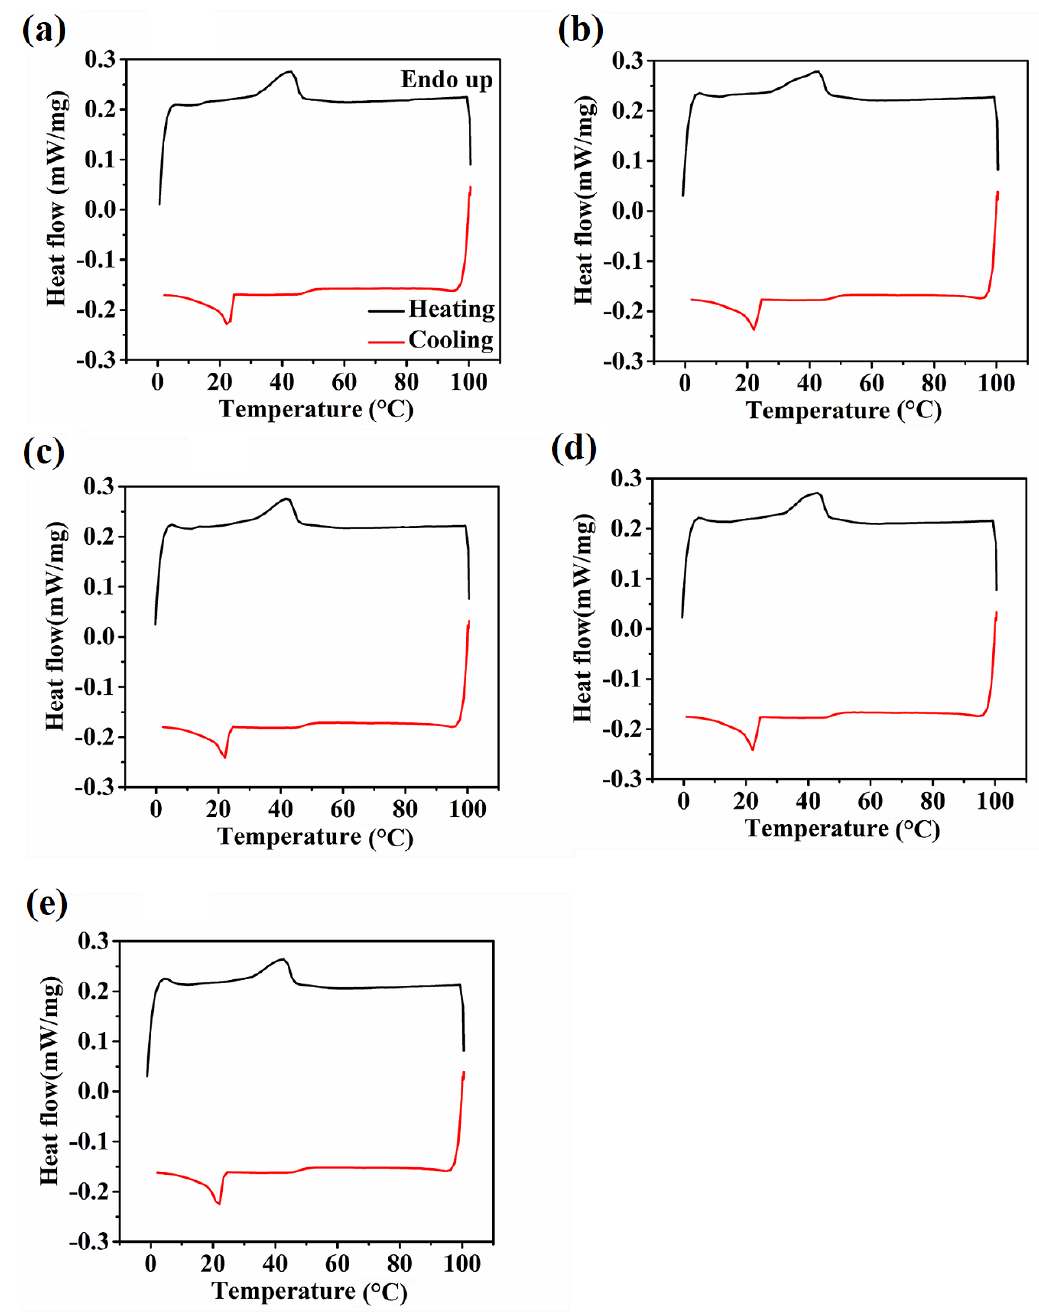
Figure 7. Thermograms of oleogel samples: ( a ) SE0, ( b ) SE1, ( c ) SE3, ( d ) SE5, and ( e ) SE10.